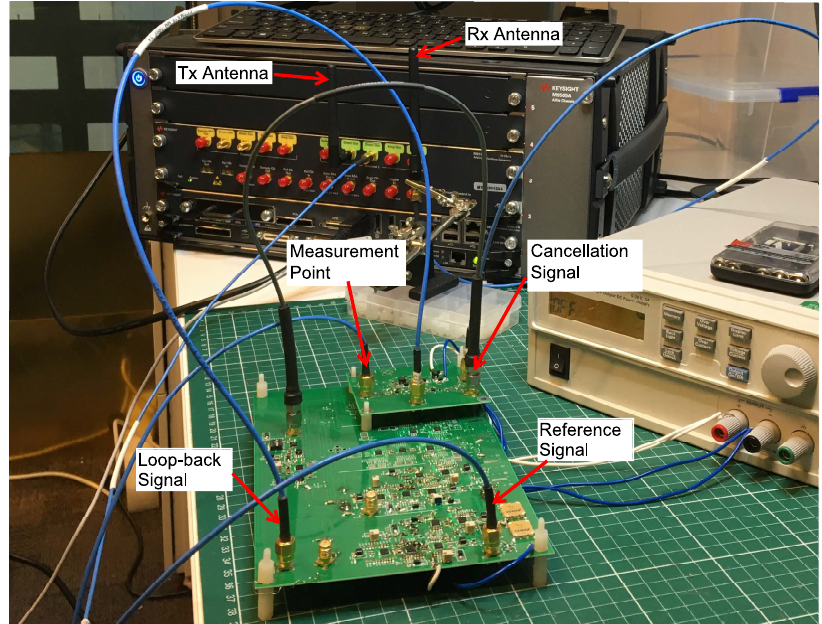
Figure 6. The measurement